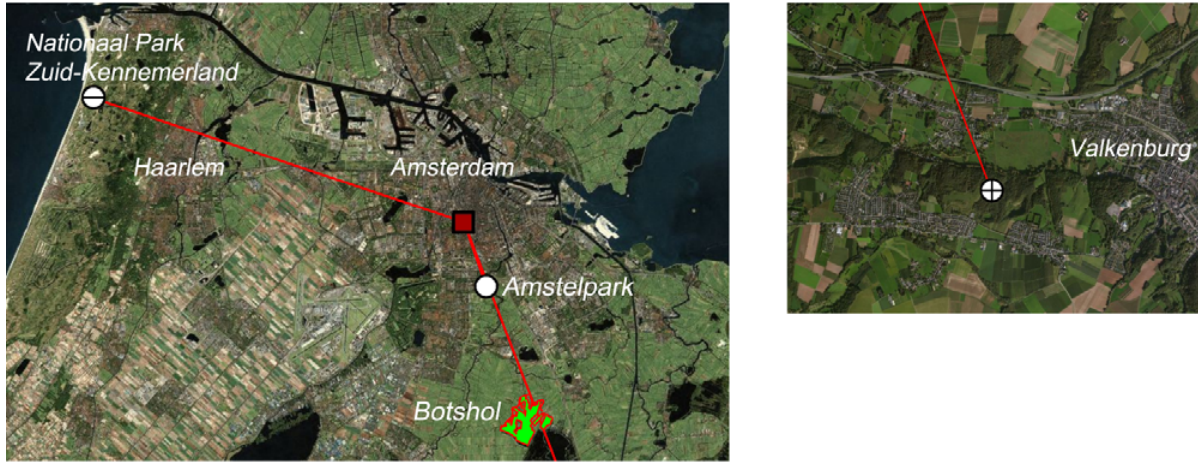
Figure 2. An example: the favourite natural places on three spatial levels of an Amsterdam